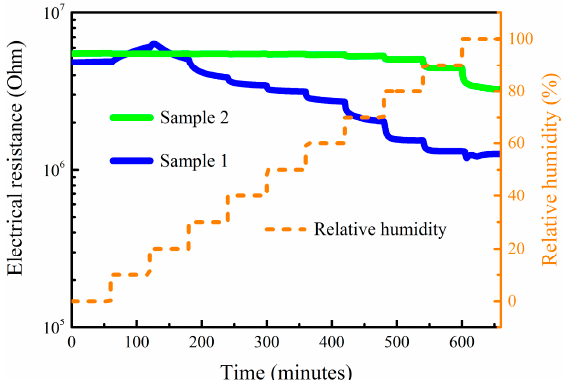
Figure 7. Effect of humidity on the base resistance of the samples illuminated by blue light at room